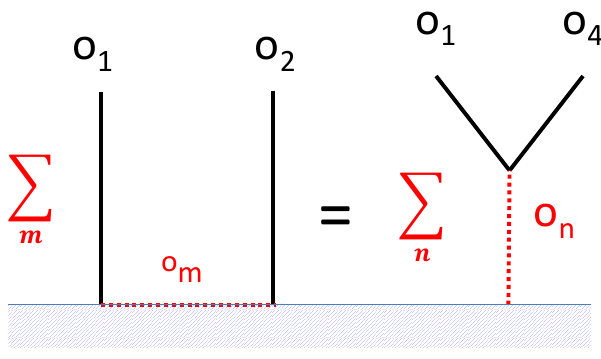
Figure 1 . Two-point function crossing symmetry underlying the conformal boundary bootstrap. In the presence of boundaries, one-point functions need not vanish, so the sum on the right hand side is non-trivial. Also, two-point functions can depend on one non-trivial conformally invariant cross-ratio and so there is already interesting information contained at that